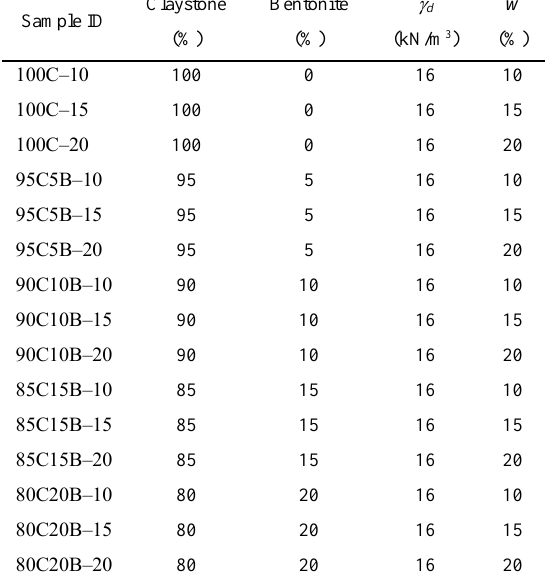
Table 2. Sample initial